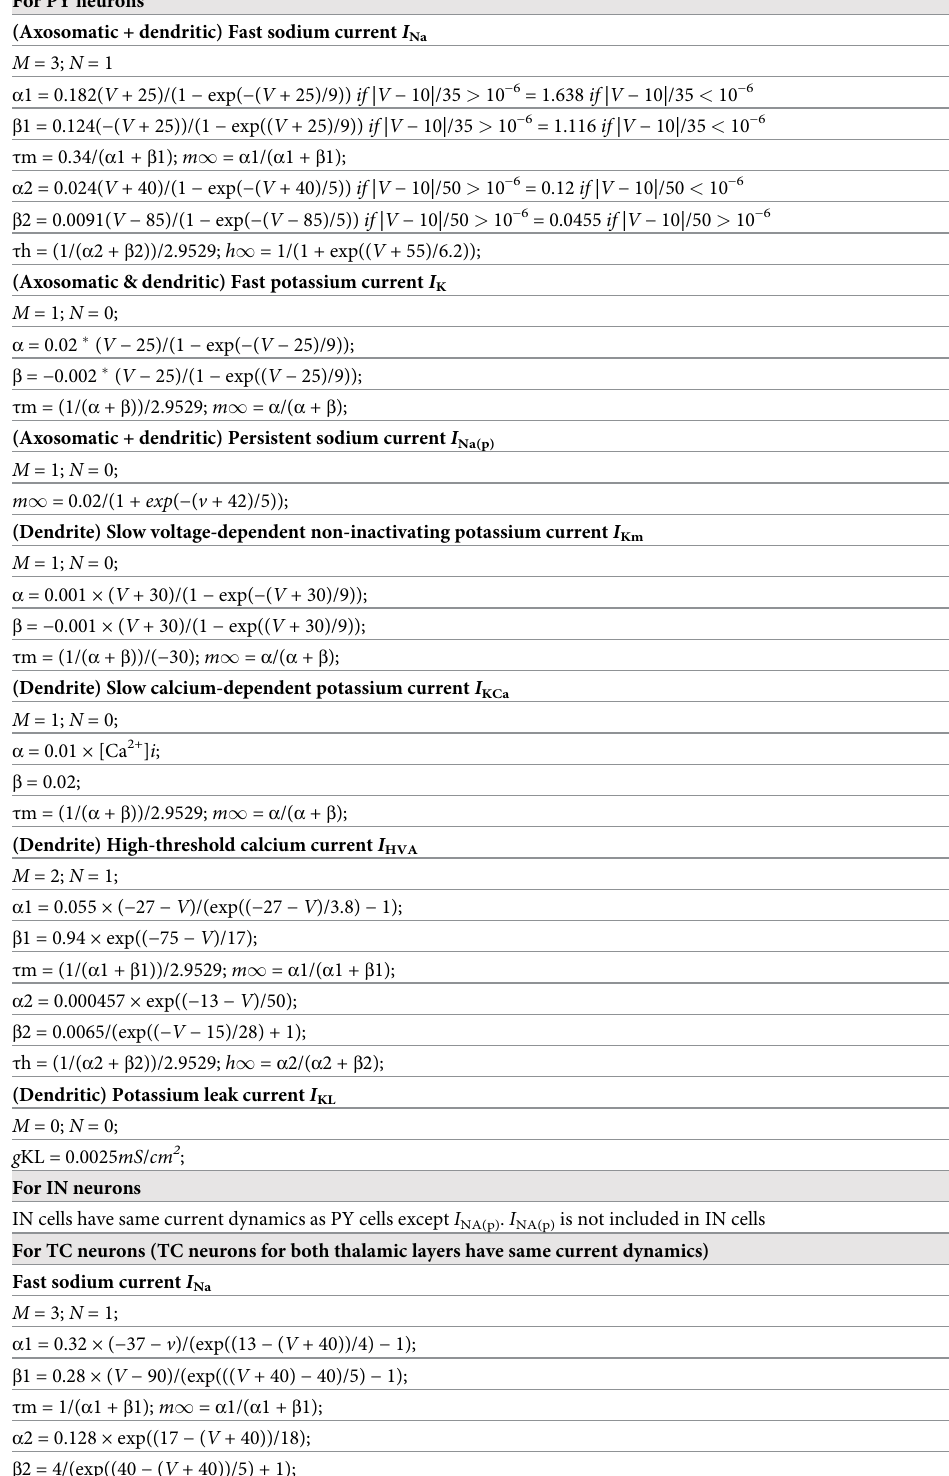
Table 1. Dynamical models of all intrinsic currents. For PY